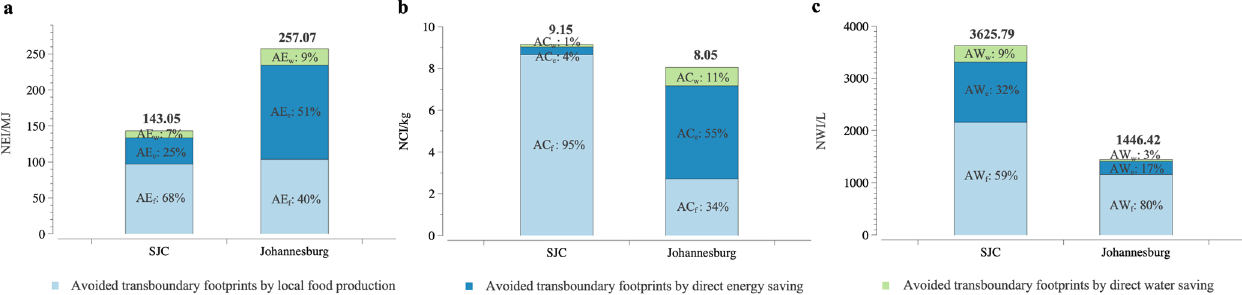
Fig. 4 Structural analysis for nexus index of green roofs per square meter. a Avoided transboundary energy footprints, the total value is de fi ned as Nexus Energy Index (NEI) which is the sum of AE f , AE e , AE w . b Avoided transboundary carbon footprints, the total value is de fi ned as Nexus Carbon Index (NCI) which is the sum of AC f , AC e , AC w . c Avoided transboundary water footprints, the total value is de fi ned as Nexus water Index (NWI) which is the sum of AW f , AW e , AW w . Bold numbers on top of each bar indicate the total value of the nexus